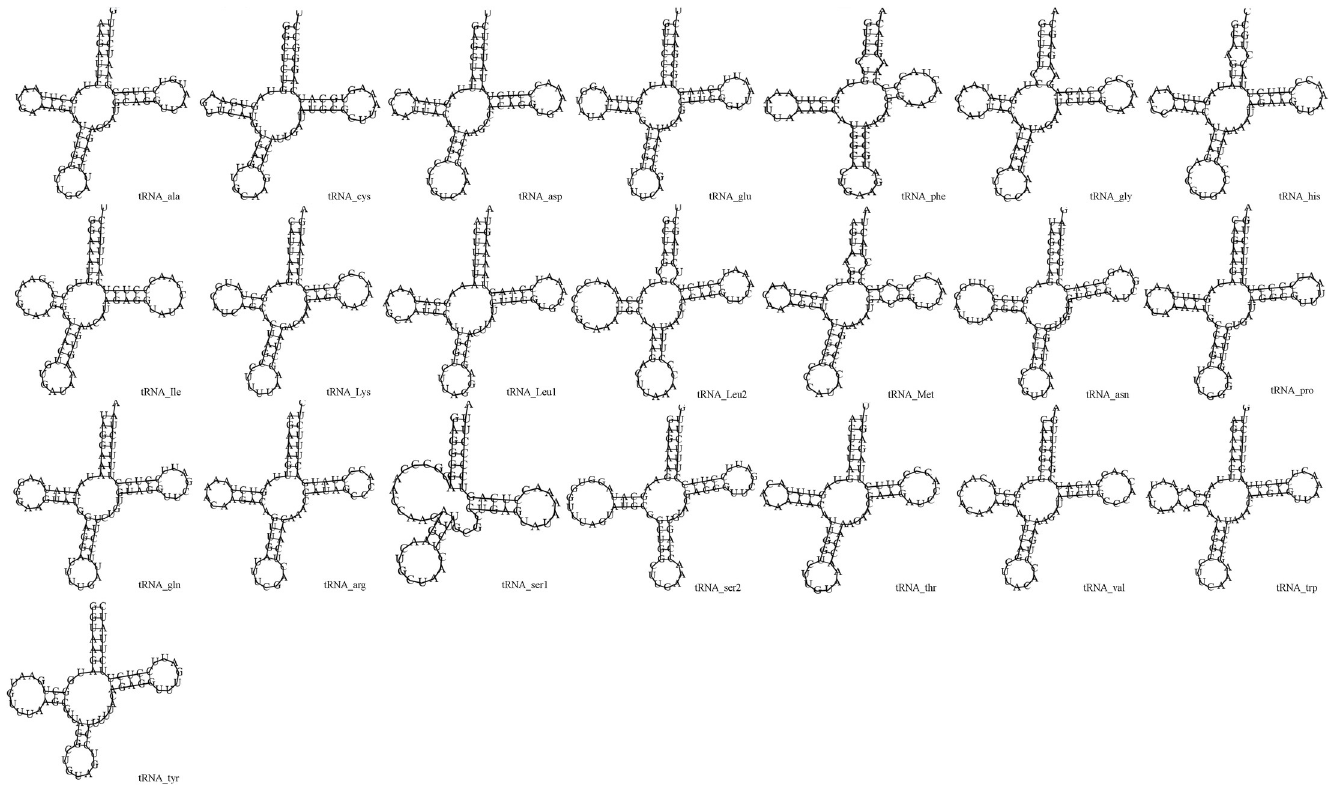
Fig 4. Putative secondary structures of the 22 tRNA genes of P . cyanocephala .